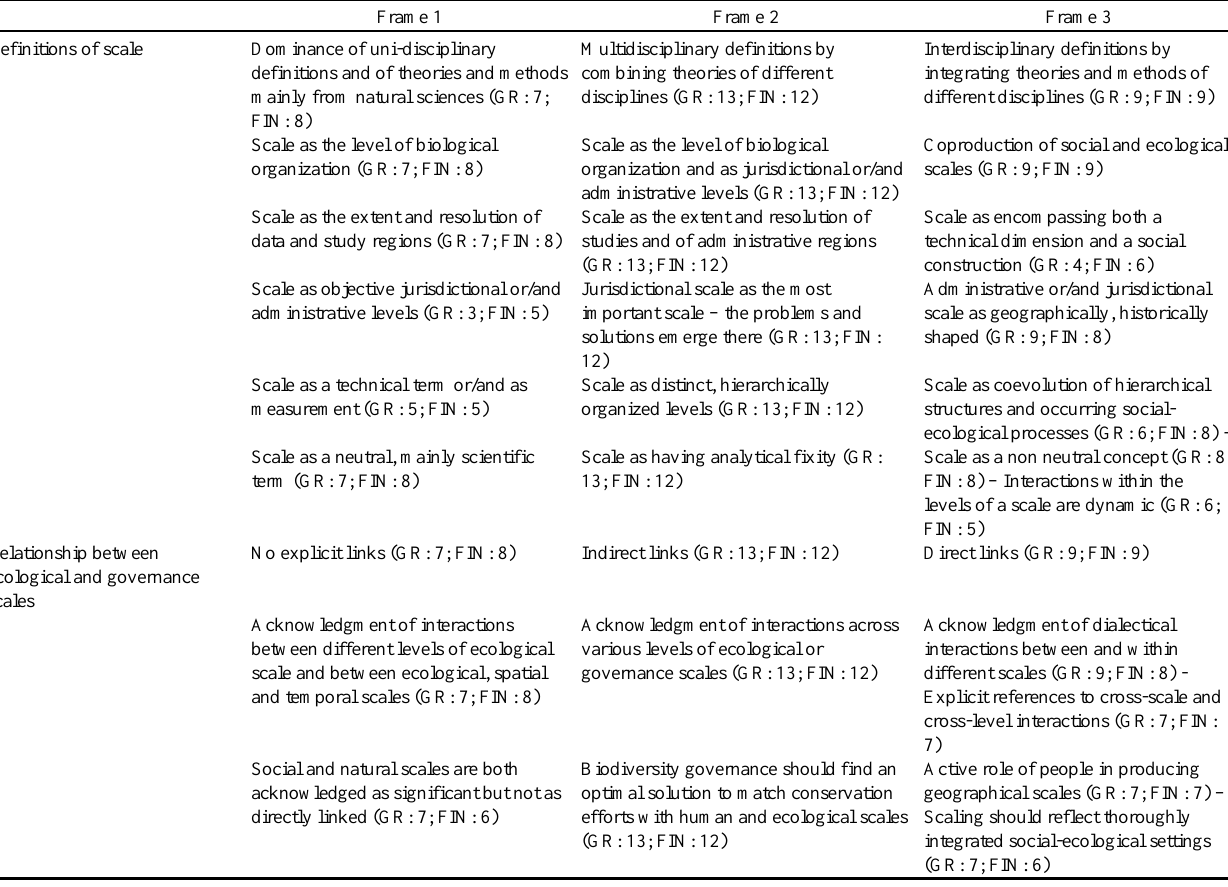
Table 2 . The outcomes of frame analysis regarding definitions of scales and of the relationship between ecological and governance